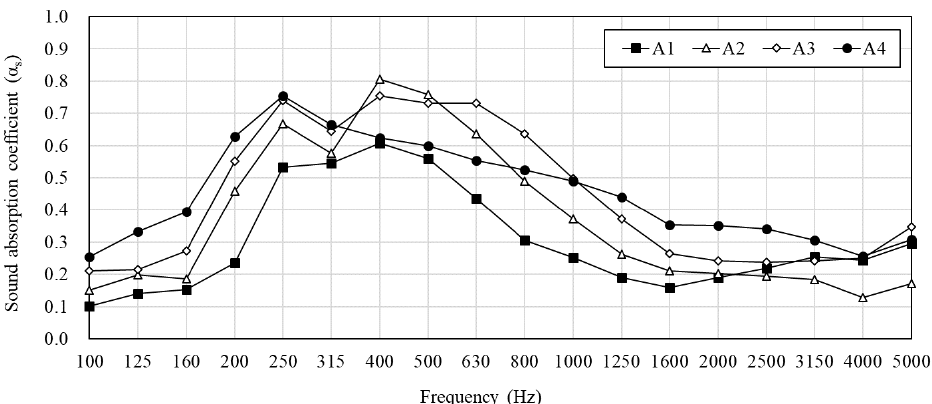
Figure 9. The sound absorption coefficient of Group A in stage 2 (specimen height 10 cm). A1: canvas with 5.8 cm air-layer + EMM with 3 cm air-layer; A2: canvas with 3.8 cm air-layer + EMM with 5 cm air-layer; A3: canvas with 1.3 cm air-layer + EMM with 7.5 cm air-layer; A4: canvas with 0 cm air-layer + EMM with 10 cm air-layer.